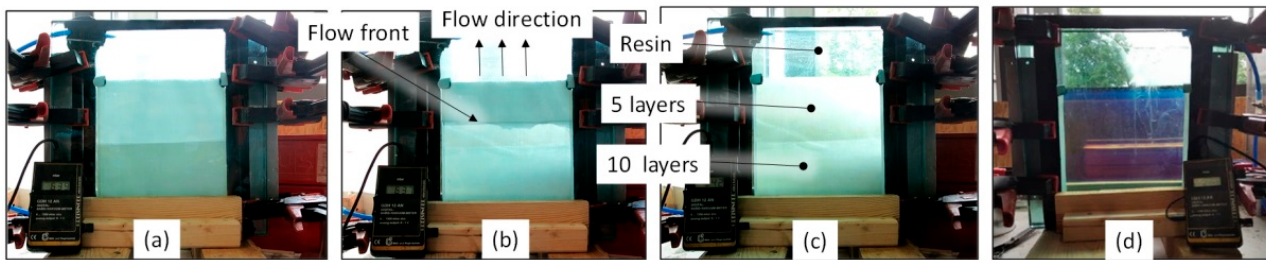
Figure 4. The L-RTM vacuum infusion states on the example of a preform ( a ) pre-infusion ( b ) during infusion ( c ) after infusion and set for cure ( d ) after 24 h of curing, with resin only (up), 5 layers (middle) and 10 layers (below).